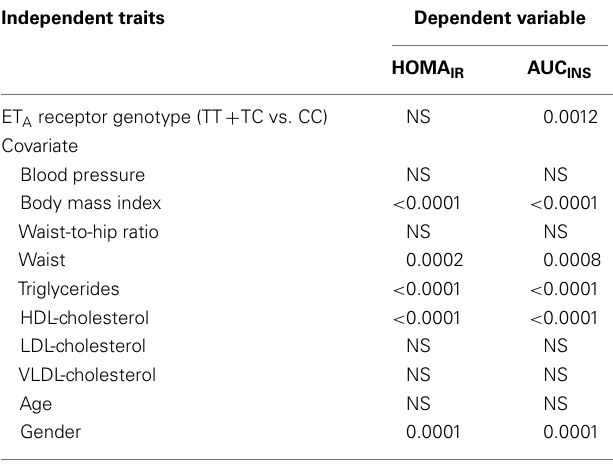
Table 5 | Results on the p -values of correlation analysis using insulin sensitivity indices as dependent variables and insulin resistance related traits and genotypes as independent variables